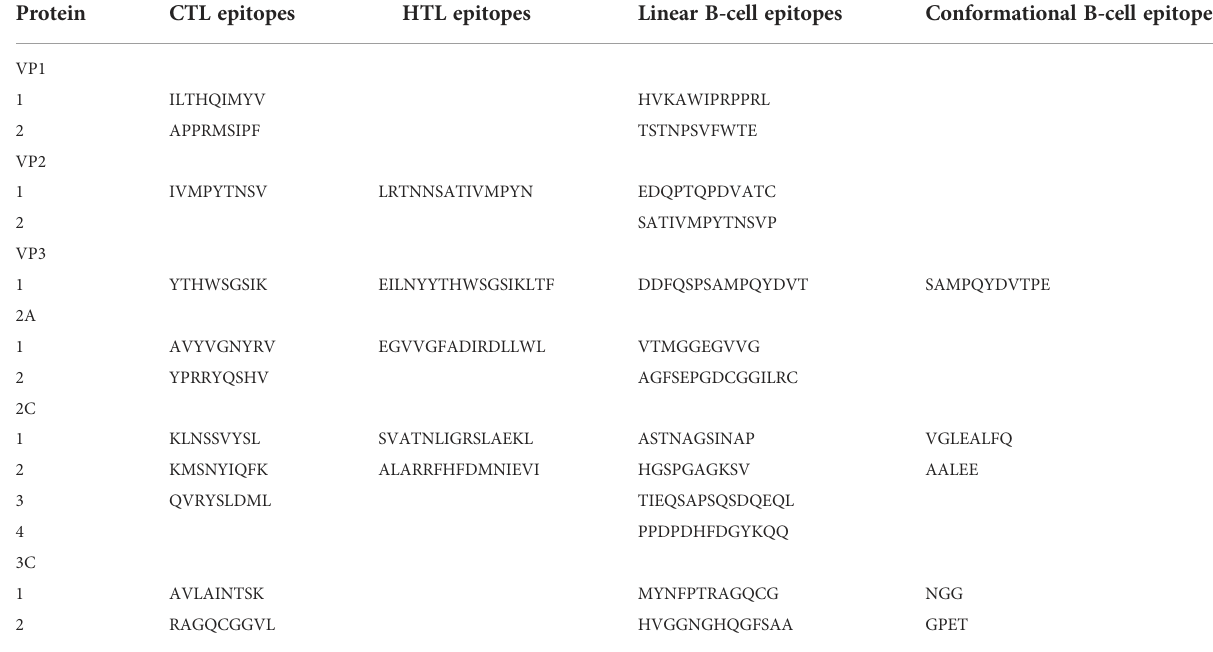
TABLE 6 Highly conserved epitopes used for the fi nal vaccine construction.